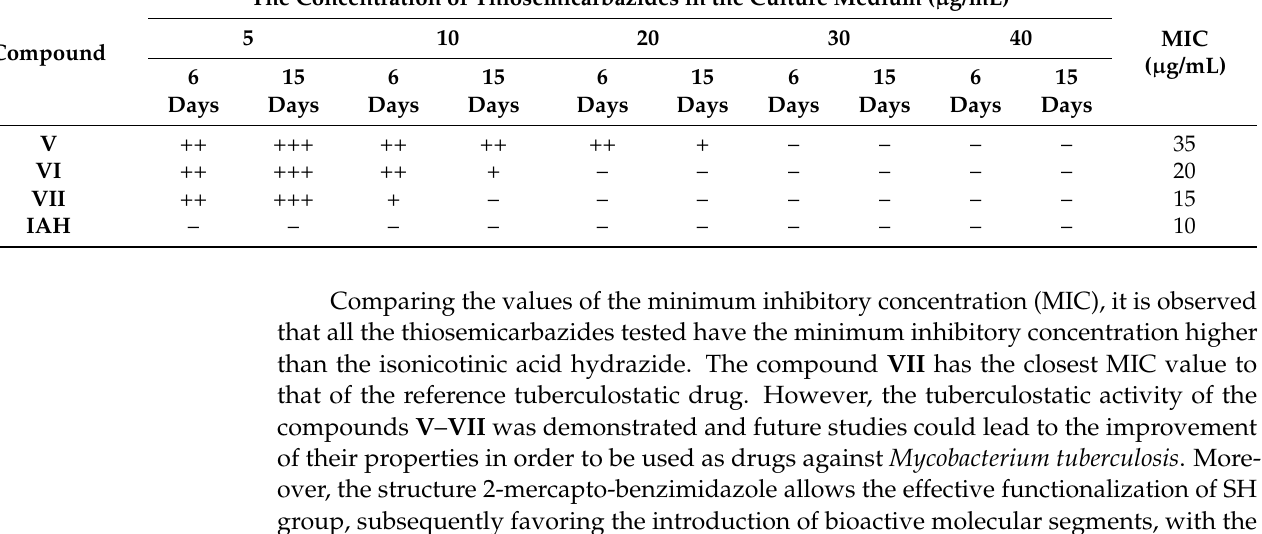
Table 5. Tuberculostatic activity of thiosemicarbazides V–VII against Mycobacterium tuberculosis , in vitro compared to isoniazid (IAH).